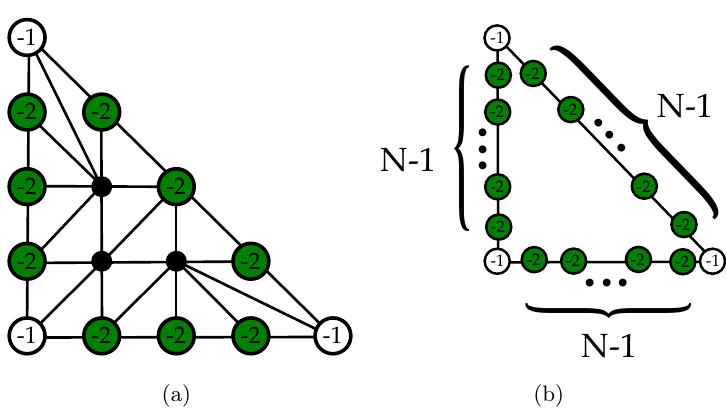
Figure 3 . (a) Fully triangulated toric fan for T 4 : the internal vertices are the compact divisors, as- sociated to the Cartans of the gauge group. We marked the external vertices by the self-intersection numbers of the non-compact divisors with the compact divisors. These form the combined (cid:12)ber diagram (CFD): ( (cid:0) 2) are the marked vertices, which form the subgraph that is the Dynkin diagram of the (cid:13)avor symmetry G F = SU( N ) 3 . ( (cid:0) 1) are the curves with self-intersection number (cid:0) 1, which correspond to matter hypermultiplets in bifundamentals in pair-wise combinations of the SU( N ) 3 (cid:13)avor symmetry. (b) the CFD for T N .